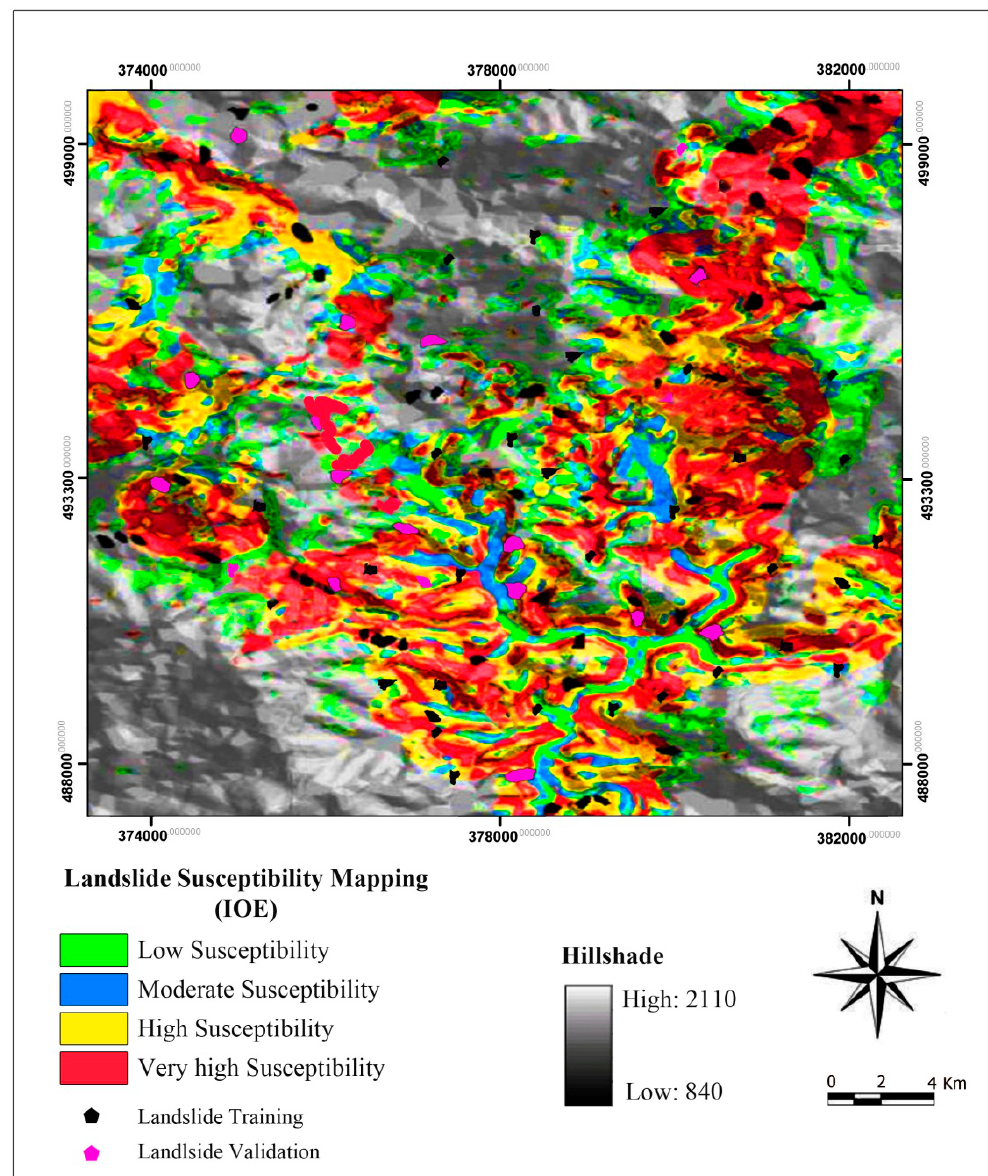
Figure 10. Landslide susceptibility map produced by the IOE model.